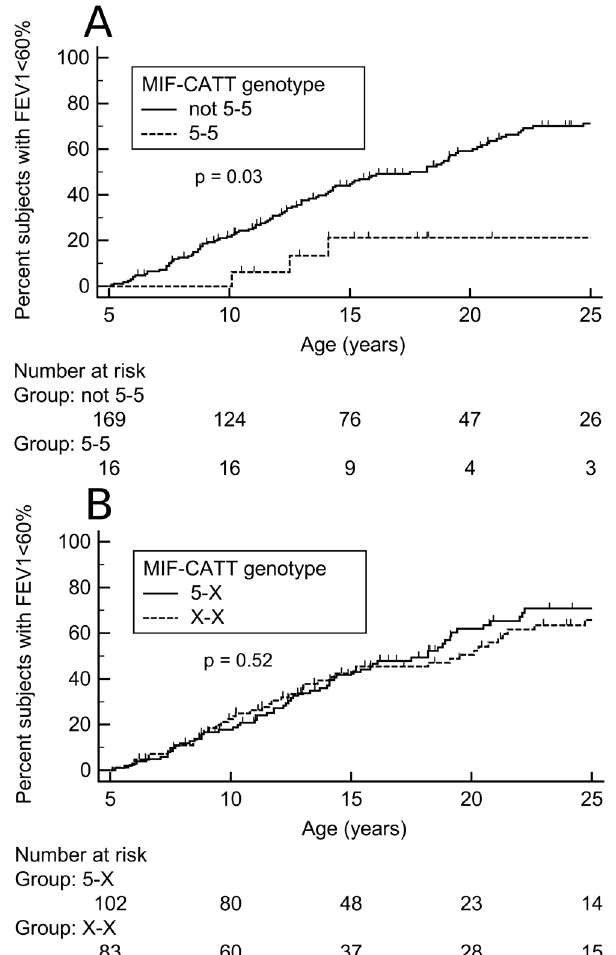
Fig. 1. Lung function decline in 185 Cystic Fibrosis patients grouped according to MIF -794 CATT genotypes. Kaplan-Meier plots relative to age at first acute episode with FEV1 , 60% of predicted value. (A) Comparison between patients with MIF 5-5 (homozygous 5-CATT repeats) vs. not 5-5 genotype; (B) comparison between patients with at least one 5-CATTallele vs. the others. Ticks indicate censored subjects follow-up times. ‘‘Number at risk’’ at the bottom indicates the number of patients without acute episodes at a given time interval and whose follow- up extends at least that far into the